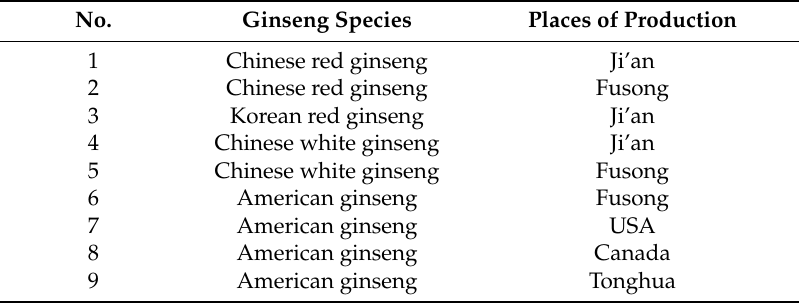
Table 1. Details of the ginseng